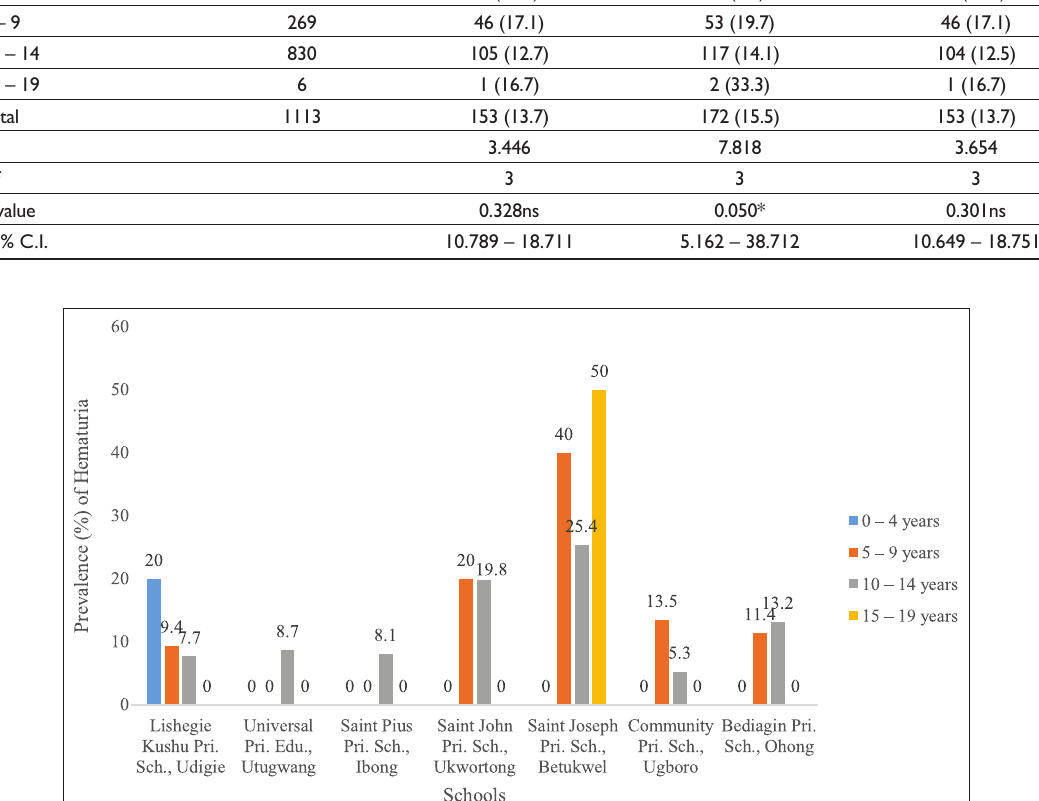
Figure 2: Prevalence of Hematuria in Relation to Age and School in the Study